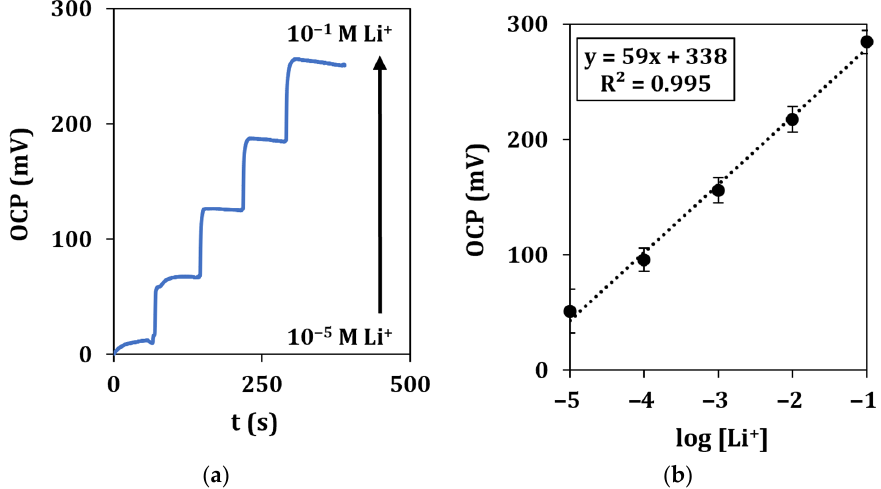
Figure 7. Microflow lithium detection in standard solutions. ( a ) Recorded OCP signals vs. time for a total duration of 500 s at a flow rate of 0.2 mL/min and ( b ) corresponding calibration curve. Each measurement was repeated at least 5 times using the same sensor.